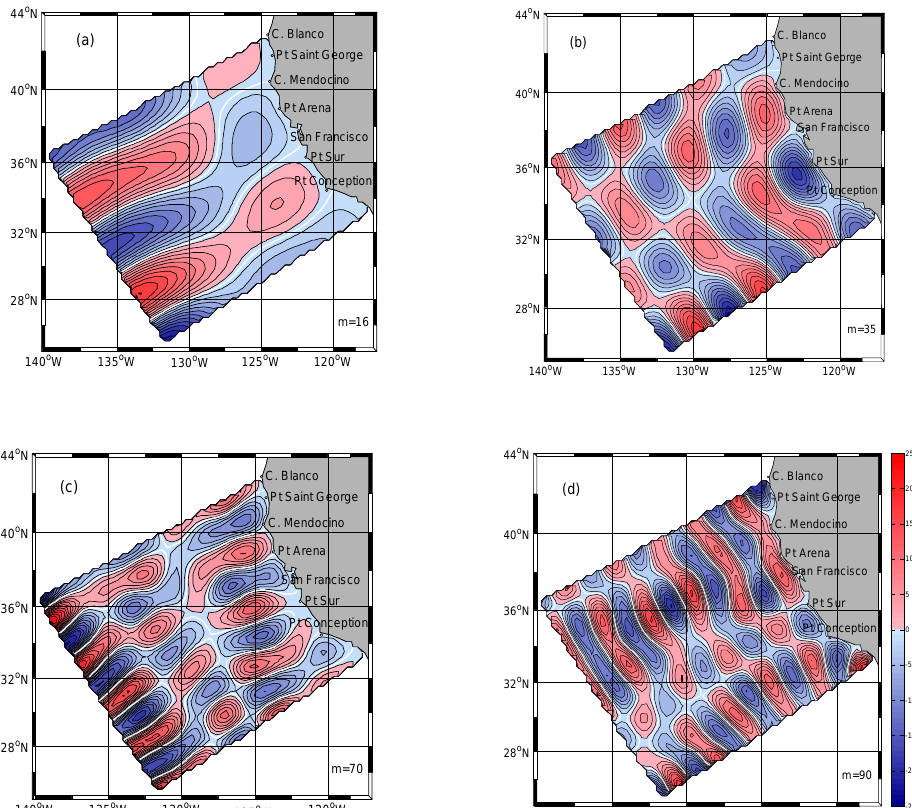
Figure 1. Structure of basis functions (M-modes, 9 m × 10 5 ) used for calculations. (a) m =16, (b) m =35, (c) m =70, and (d) m =90. White contours are zero